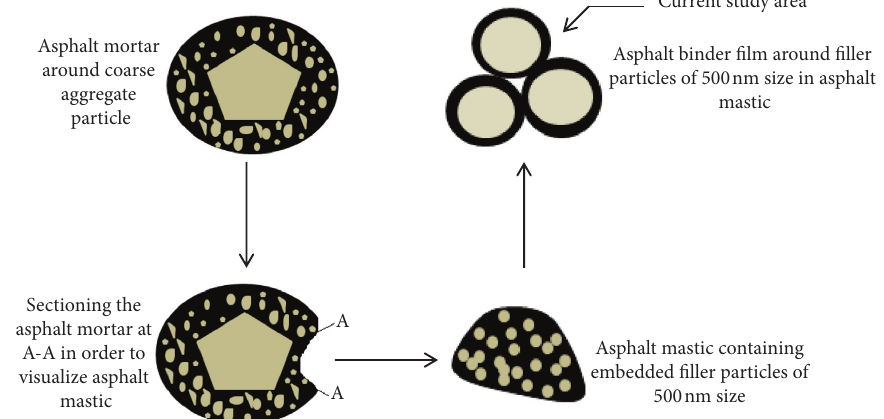
Figure 2: Flow chart showing research area.